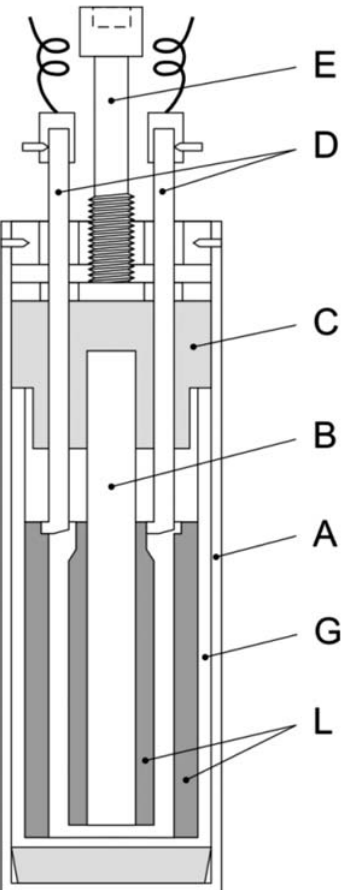
Figure 1. Sketch of the cell with two Li-electrodes (L) in a glass container (G). The cell is assembled in a steel cylinder (A). B is a glass tube supporting the inner Li-electrode, C is a Teflon lid, D points out the SS electrode terminals, and E is a screw which keeps the Teflon lid pressed onto the glass